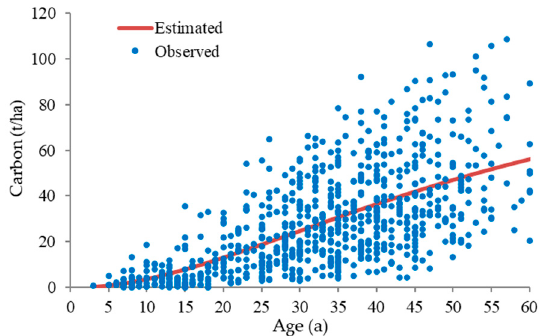
Figure 3. The fitting effect of carbon growth in the P. massoniana plantation.